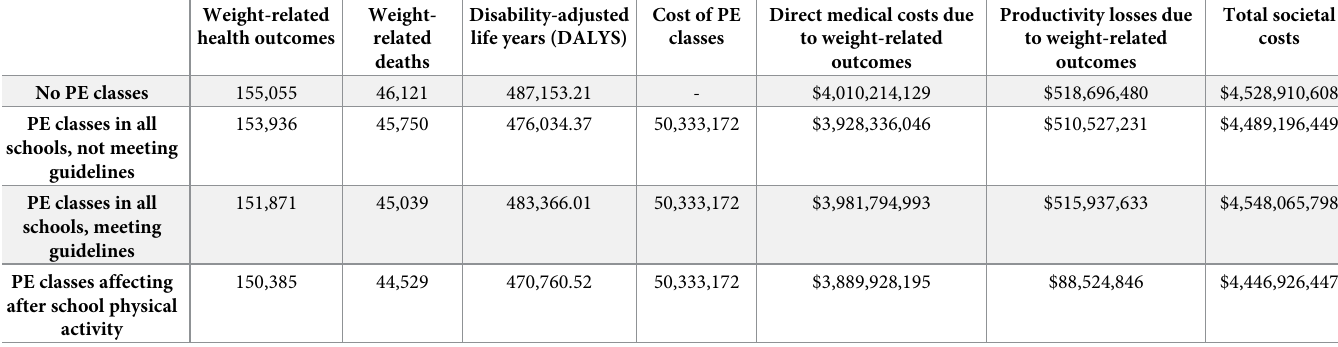
Table 1. Clinical and economic outcomes when no schools offer physical education (PE) classes and when requiring PE